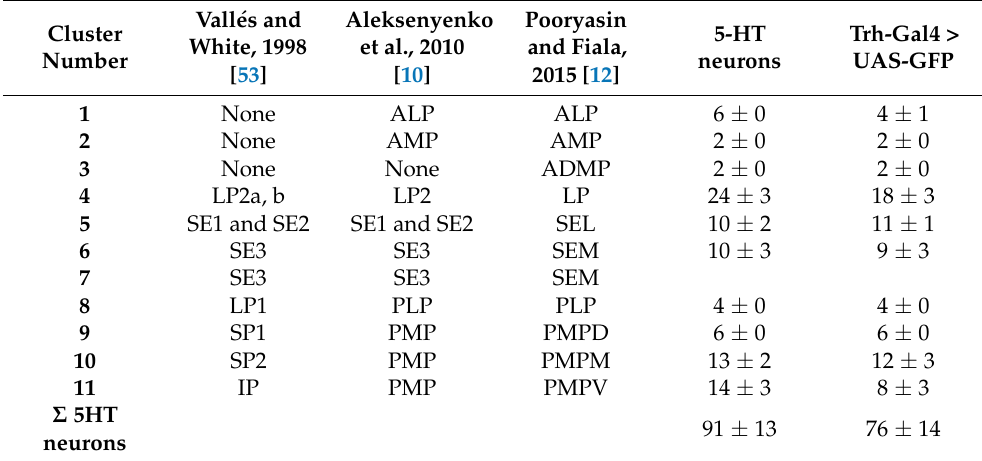
Table 1. Historical nomenclature of serotonergic clusters according to the distribution and number $ of neuronal somas & .